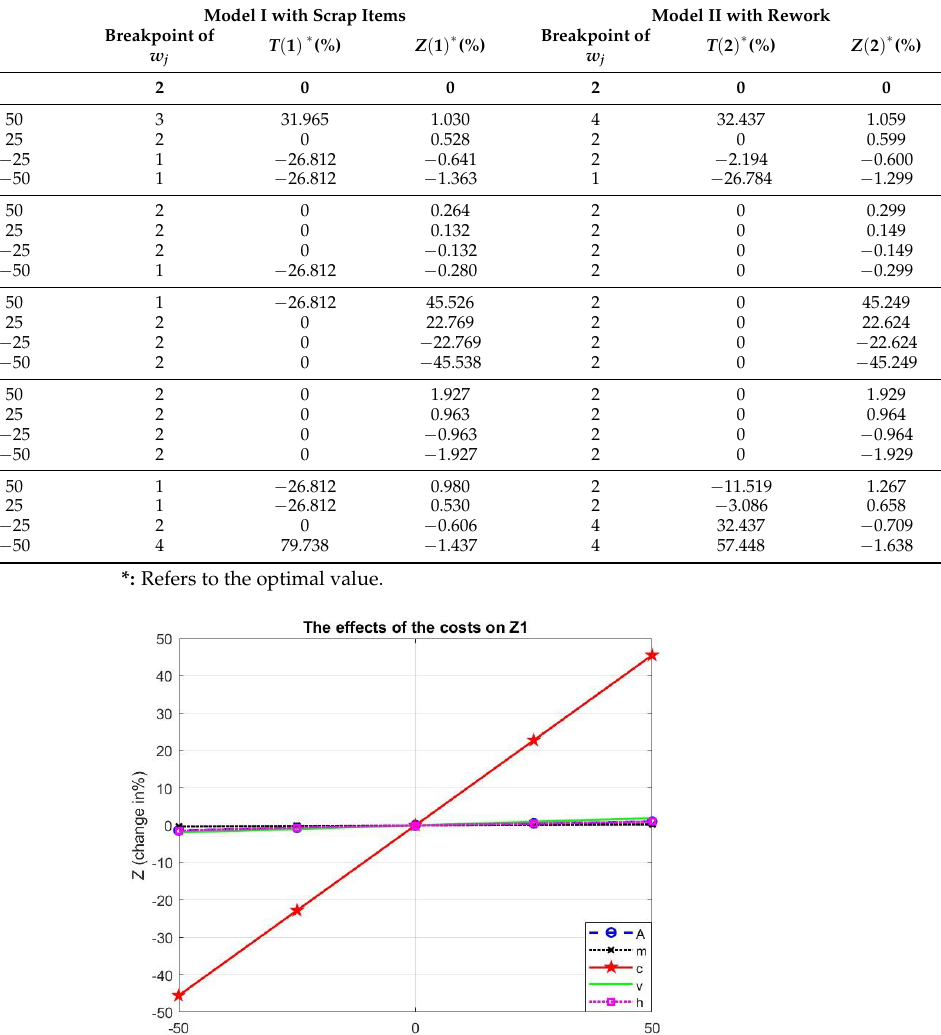
. Figure 6. The effects of the system parameters of the numerical example on the total cost of the first model.